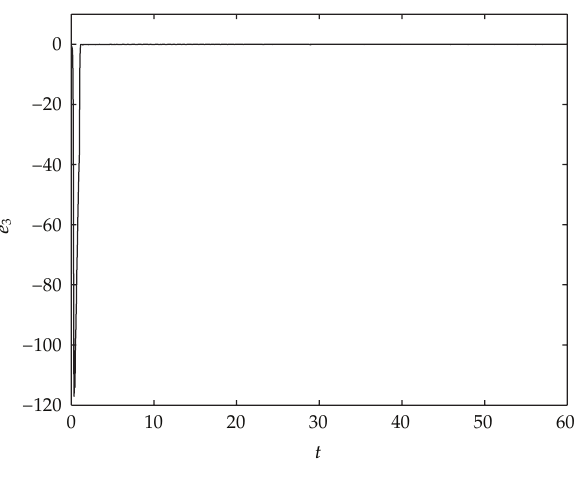
Figure 5: Synchronization error e 3 .